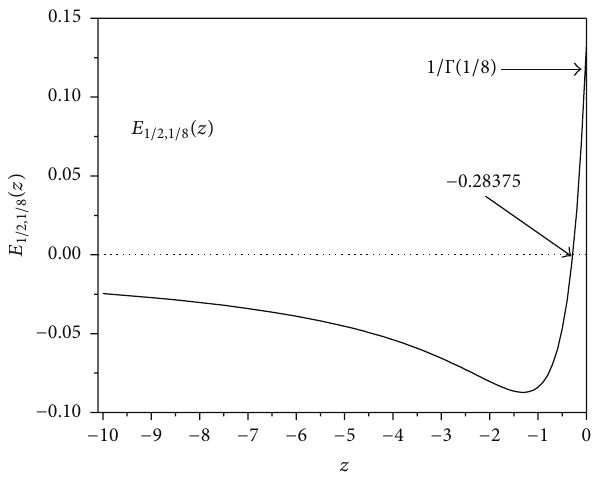
Figure 4: Typical Mittag-Leffler function in phase [0/∞] 𝛼≥1